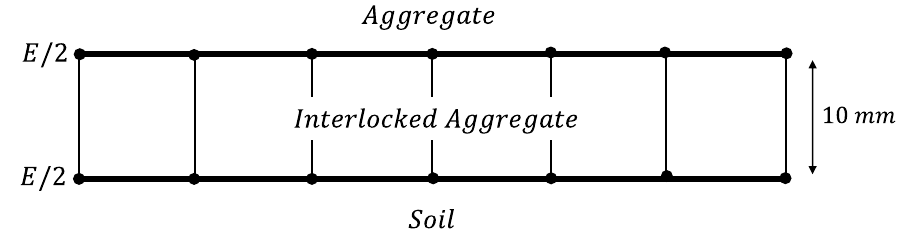
Figure 3. Geogrid–aggregate interlocking effect